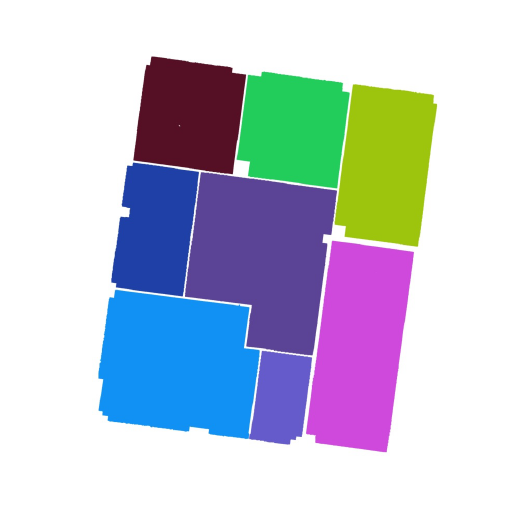
Figure 3. Results of the room segmentation of the point cloud shown in Figure 1. Figure 4. Vertical plane segmentation (top view).